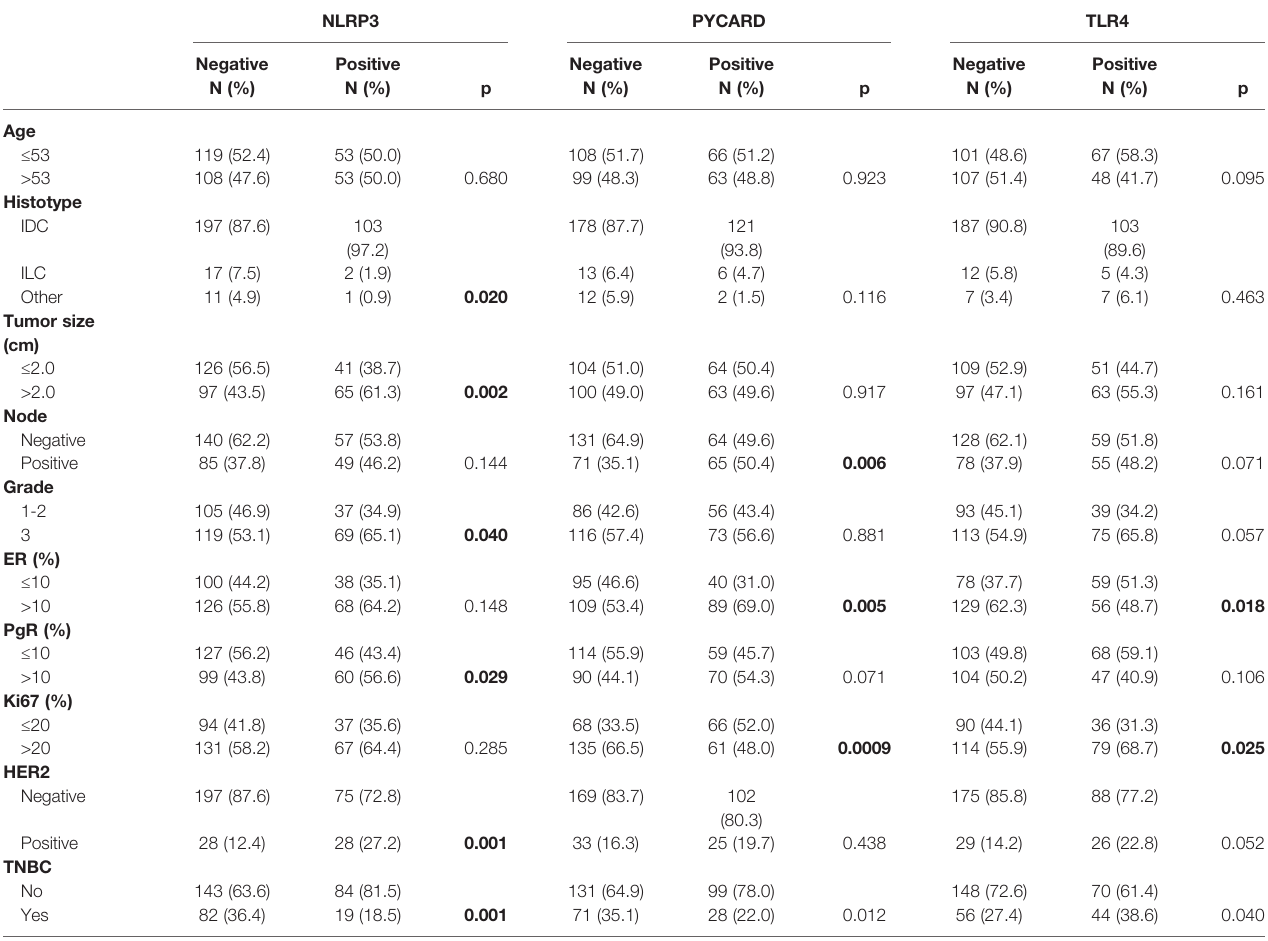
p-value of Chi-squared test for the independence of categorical variables. Bold values indicate signi fi cance. IDC, Invasive ductal carcinoma; ILC, Invasive lobular carcinoma; ER, Estrogen receptor; PR, Progesterone receptor; HER2/neu, Human epidermal growth factor receptor 2; NLRP3, NOD-like receptor protein 3; PYCARD, Apoptosis-Associated Speck-Like Protein Containing a Pyrin and CARD domain; TLR4, Toll-like receptor 4; TNBC, triple negative breast